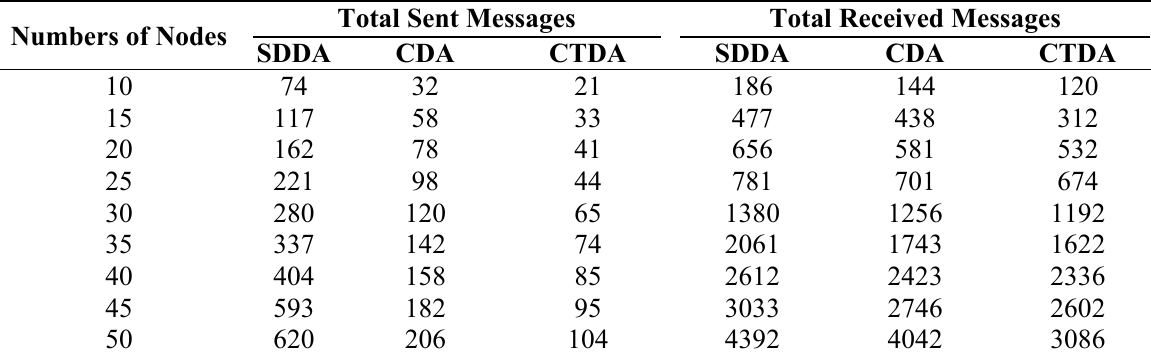
Table 3. Total messages with various numbers of